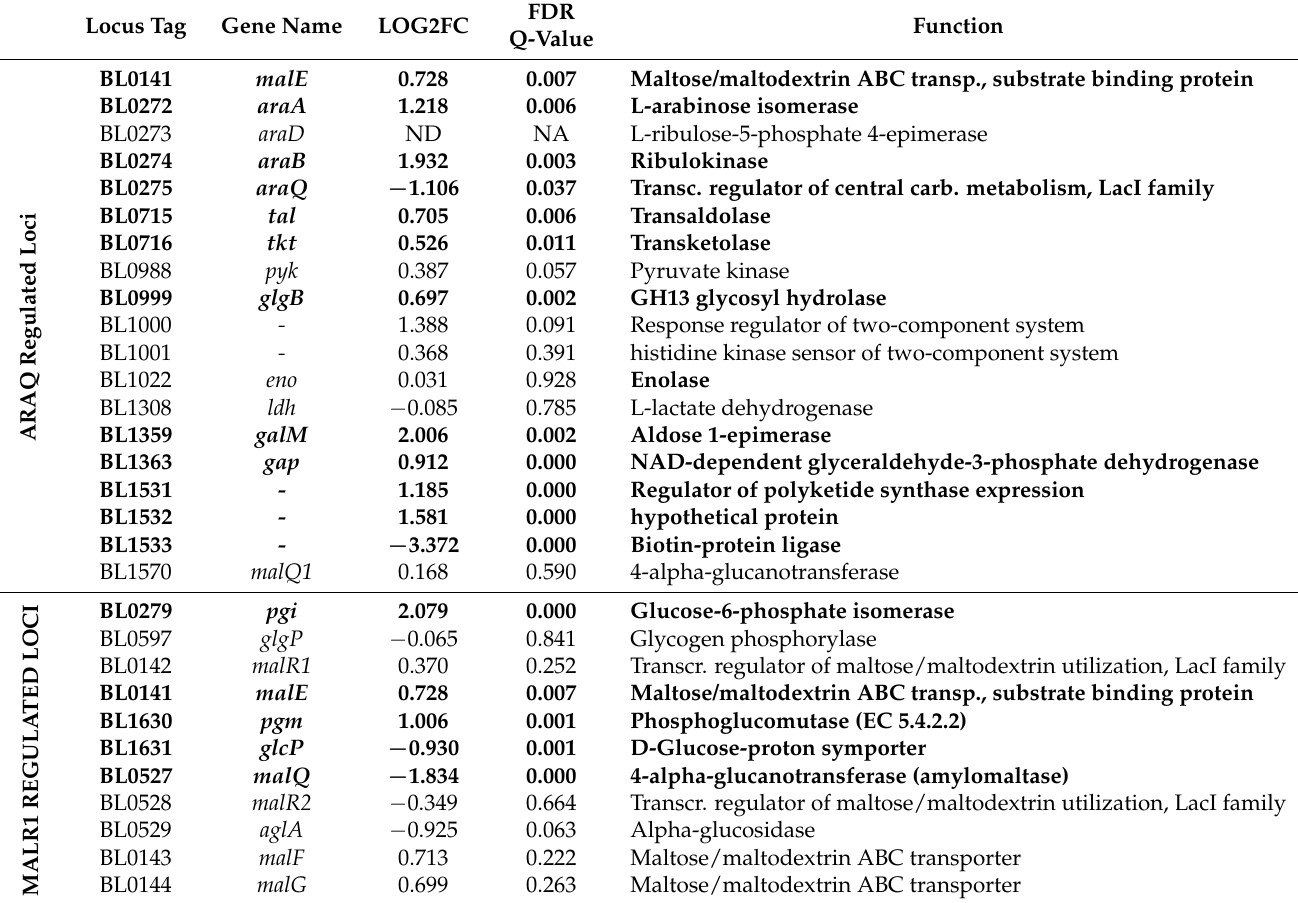
Table 2. Differential expression values of genes that are predicted to belong to the AraQ (BL0275) and MalR1 (BL0142) regulons in B. longum NCC 2705, as presented in RegPrecise. Genes showing a significant differential expression are indicated in bold. Induction during galactose growth is depicted by positive log2FC, whereas negative log2FC values represent induction during glucose